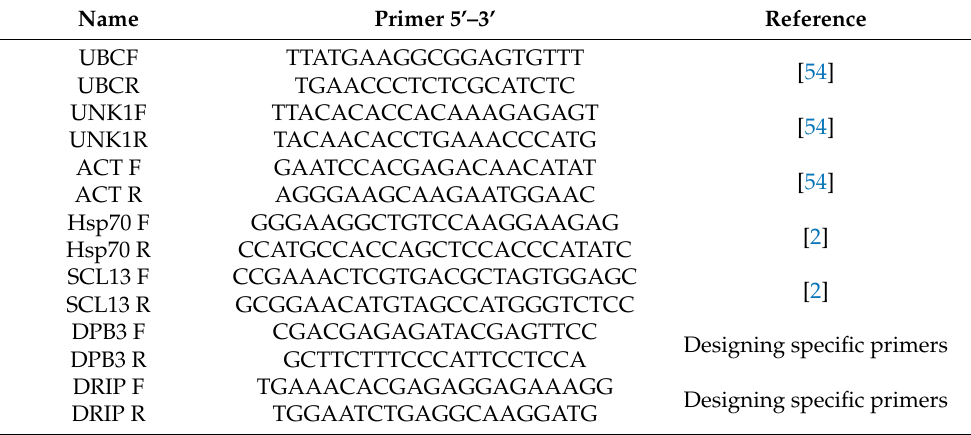
Table A1. List of primers used in this